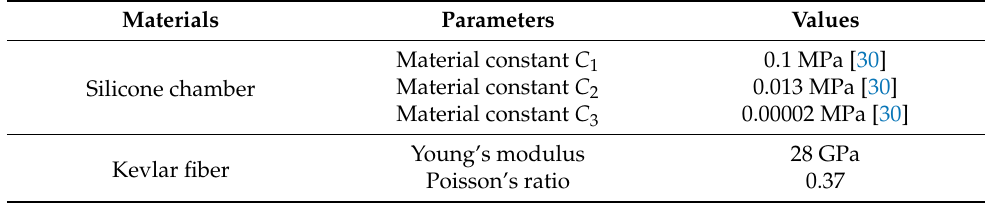
Table 2. Simulation parameters for modeling